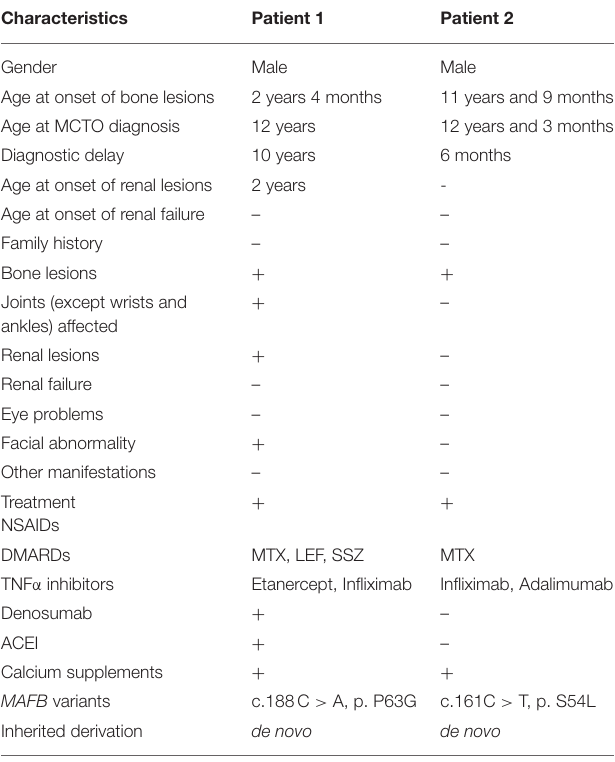
TABLE 1 | Clinical and genetic characteristics of the two MCTO patients.